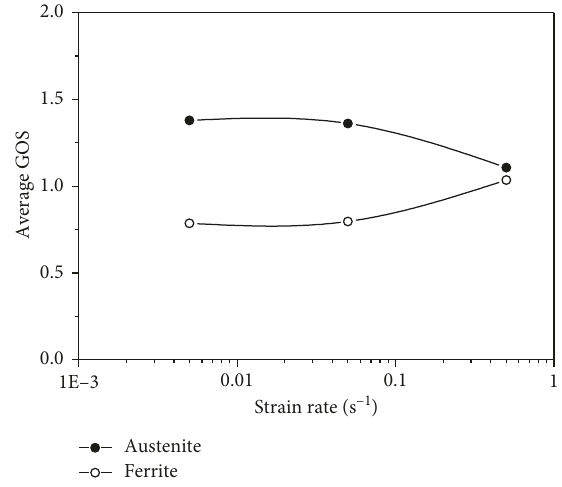
Figure 7: Relationship between average GOS and strain